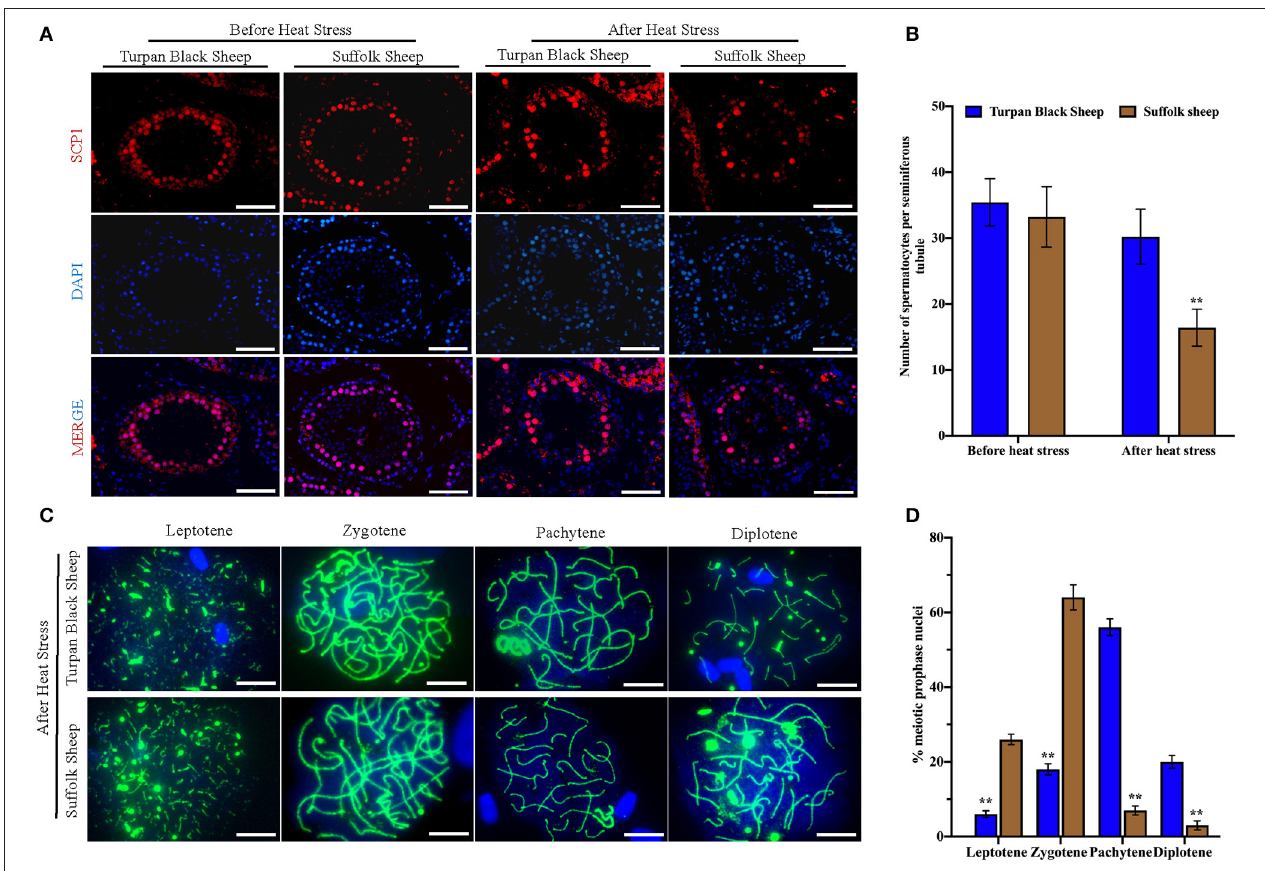
FIGURE 5 | Comparison of spermatocytes and meiosis slices after HS. (A) Spermatocyte labeled with SCP1 (red fluorescence) and nucleus labeled with DAPI (blue fluorescence), Scale = 50 µ m. (B) Number of spermatocyte positive cells in spermatogenic tubules. (C) The process of meiosis was analyzed by the method of meiotic splicing and the synaptic complex is labeled by SYCP1 (green fluorescence), Scale = 5 µ m. (D) The proportion of cells at different stages of meiosis. Significance was calculated by T -test, ** means p <